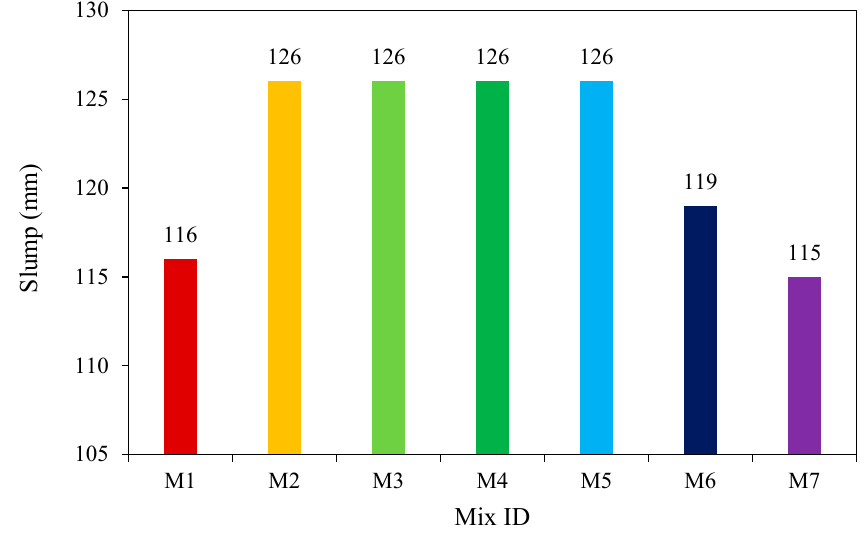
Figure 14. Variation in slump for different mixes (mm) [31].